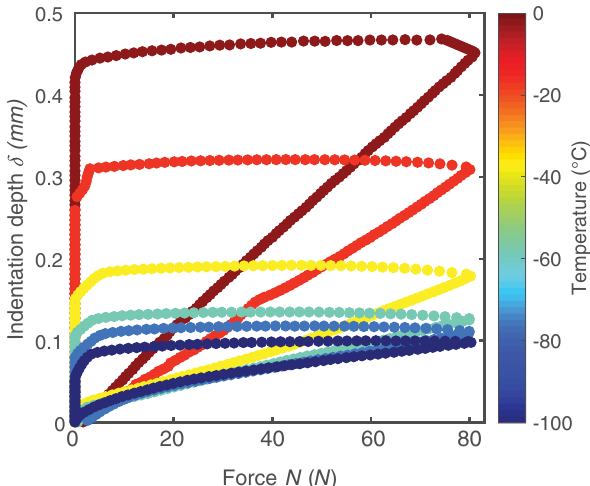
FIG. 6. Indentation depth δ as a function of the force N for an indentation speed of 3 . 8 μ m = s captured with a hardness test for various temperatures. A plastic, irreversible, loading curve is observed; after indenting up to a maximum force of 80 N, during retraction the force quickly drops. During loading, the indentation increases linearly with the indentation force, where the slope Δ δ = Δ N is inversely related to the penetration hardness. For increasing temperature, we observe a larger slope and therefore a lower penetration